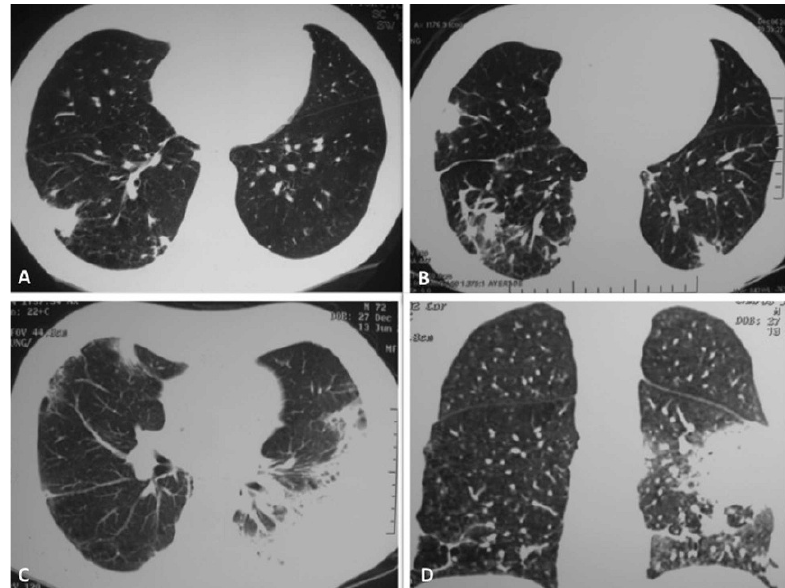
Figure 1 - Chest computer tomography (CT) scans showing different image patterns along the years. A: December, 2004: the initial clinical presentation as a subpleural solitary pulmonary nodule in the right inferior lobe with adjacent subpleural opacities. The nodule was resected and diagnosed as an inflammatory pseudotumor. B: Three years later, CT scans with multiple spiculated pulmonary nodules surronded with ground glass halo and architectural distortion of the adjacent parenchyma. C and D: June, 2008: Pulmonary nodule with ground glass halo in the middle lobe along with consolidation in the left inferior lobe resembling organizing pneumonia. There was a complete response after corticosteroid treatment.